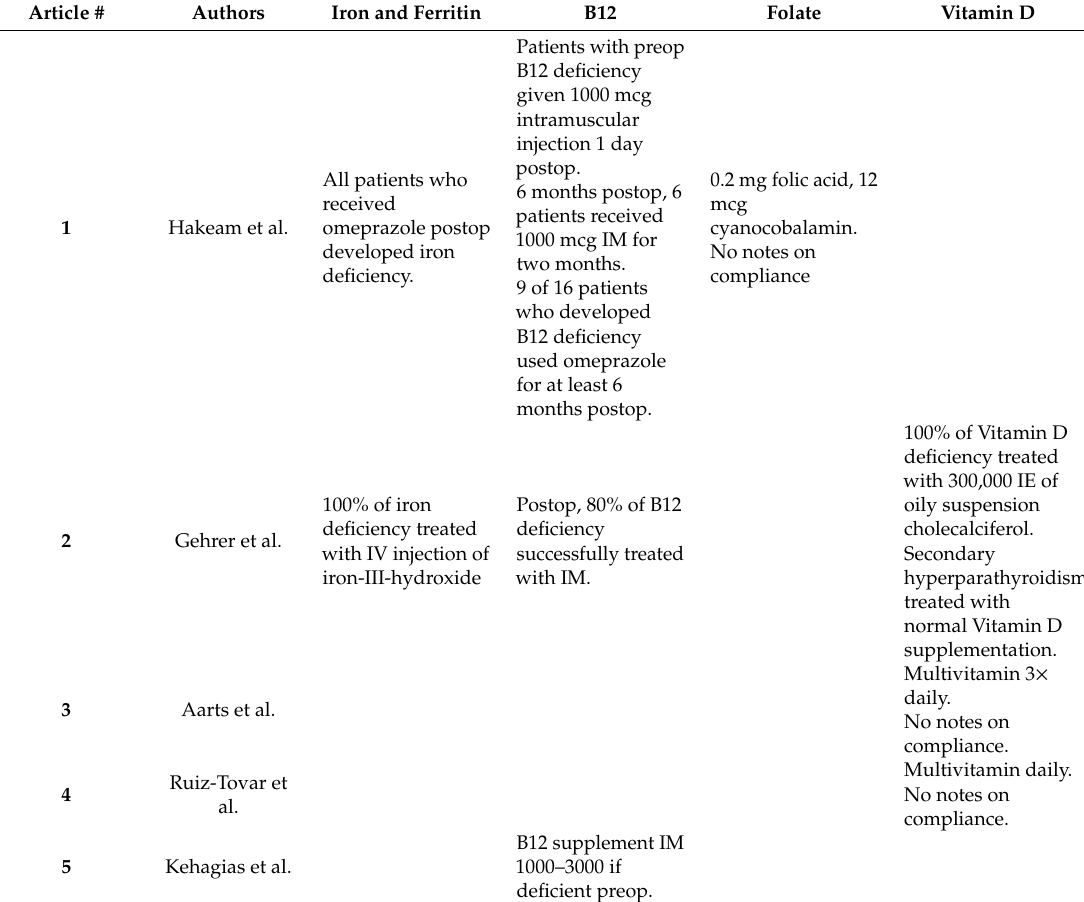
Table A1. Additional information describing supplementation regimens for each study cited